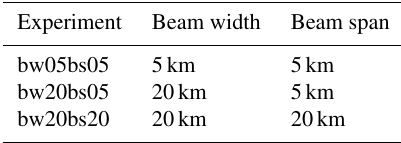
Table 2. Radar settings. The figures show the resolution at the nadir